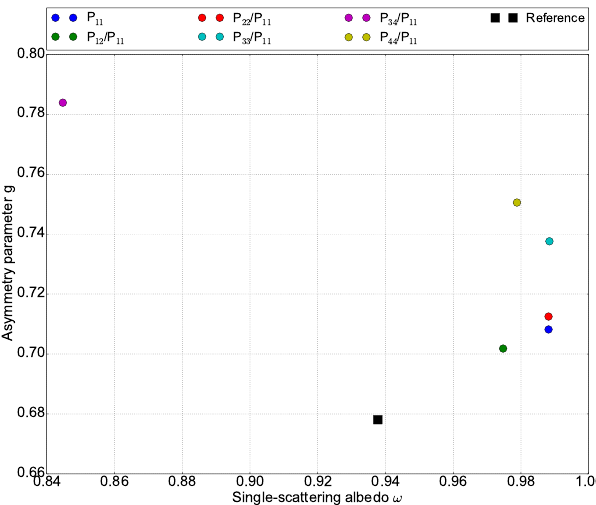
Figure 8. Variability of single-scattering albedo and asymmetry pa- rameter when the retrieval is based on fitting the ellipsoid shape distribution to individual scattering matrix elements of the particle ensemble. The true values of these parameters for the particle en- semble are also shown for